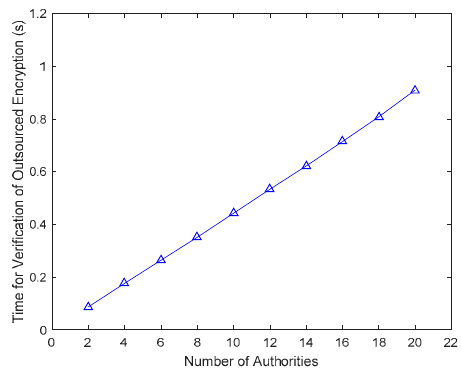
Figure 5. Computing cost for verification of outsourced encryption. Sensors 2017 , 17 , 1695